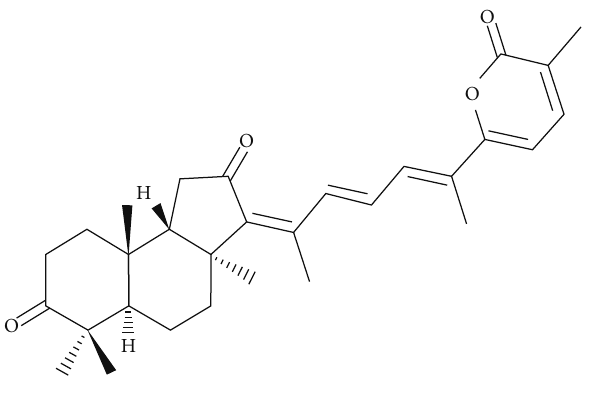
Figure 1: Structure of Stellettin